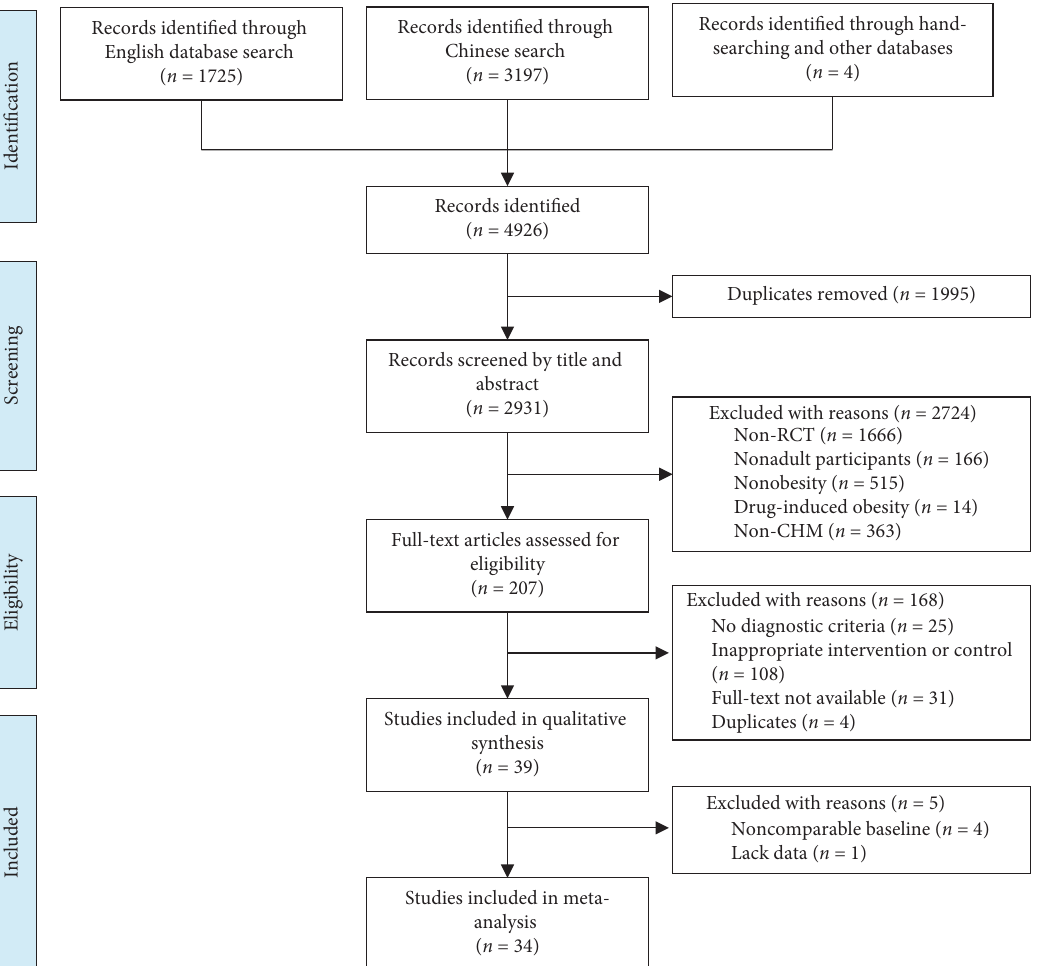
Figure 1: PRISMA flow diagram illustrating selection and exclusion of studies for qualitative review and